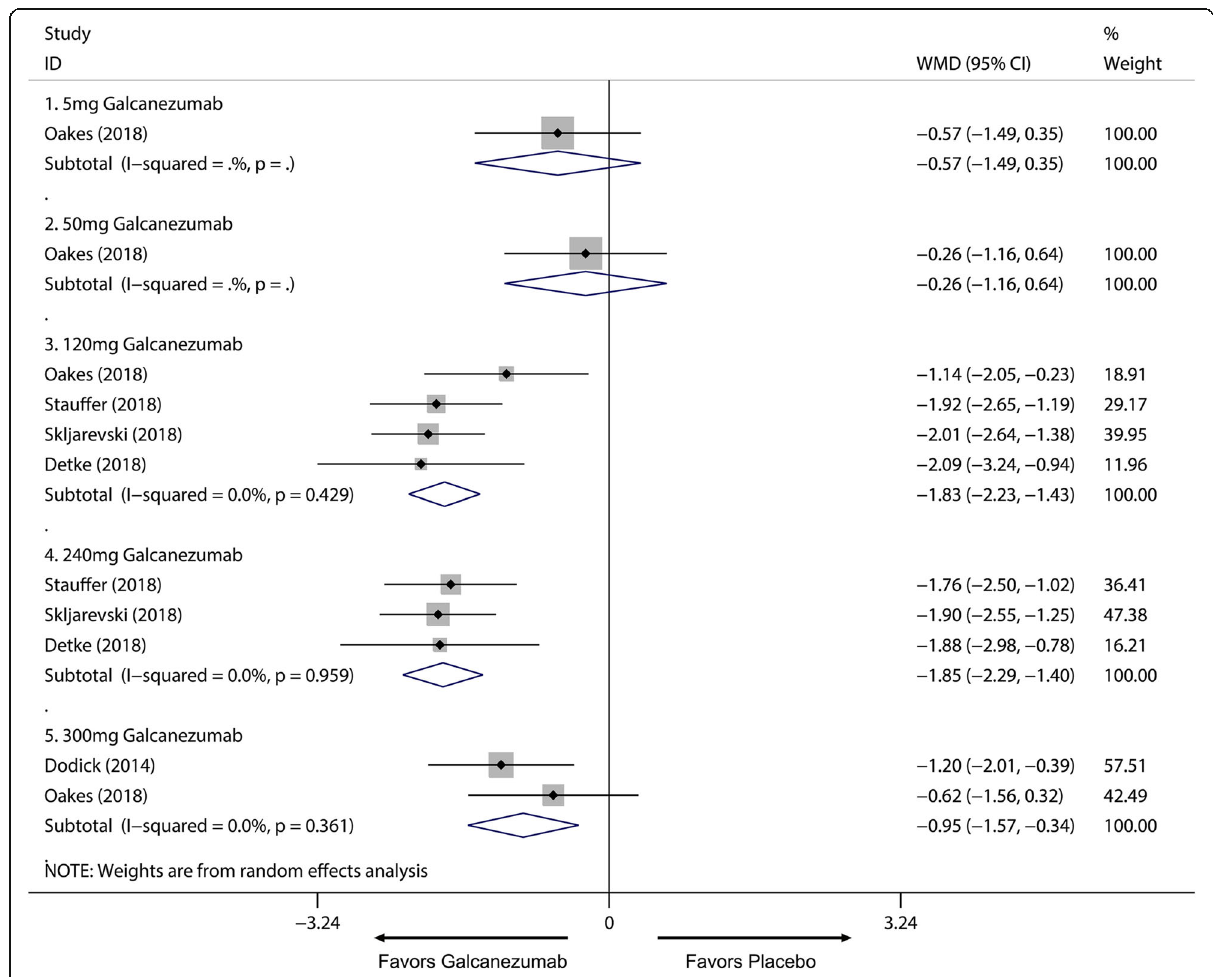
Fig. 4 The pooled weighted mean differences of the reduction of MHDs in treatment group compared with placebo in different doses, the diamond indicates the estimated relative risk with 95% confidence interval for the pooled patients. WMD weighted mean